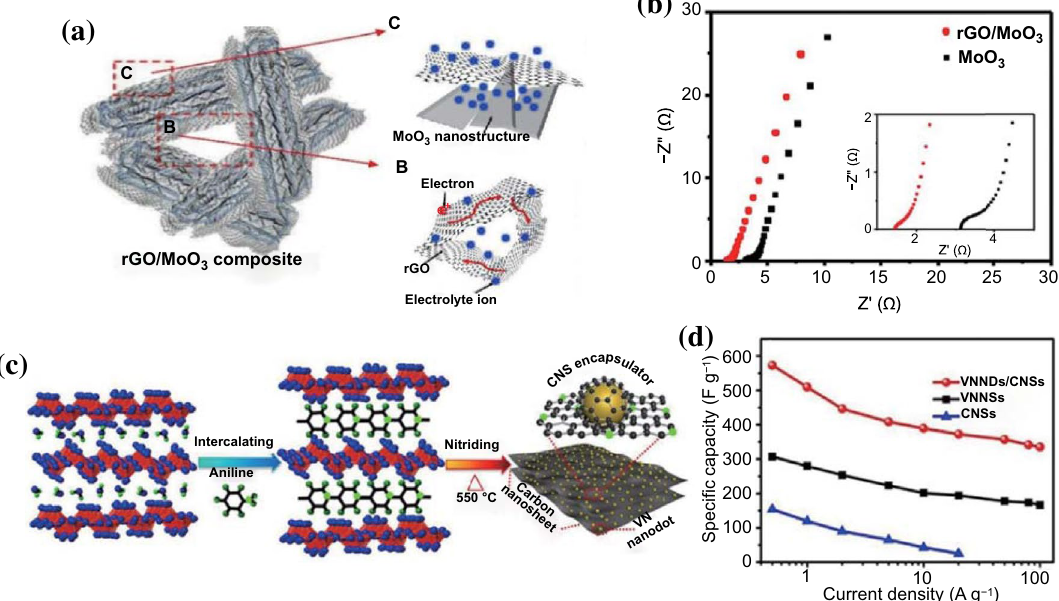
Fig. 11 a Schematic illustration of the unique structure and synergetic effect of rGO/MoO 3 composite. b Nyquist plot of the rGO/MoO 3 com- posite and